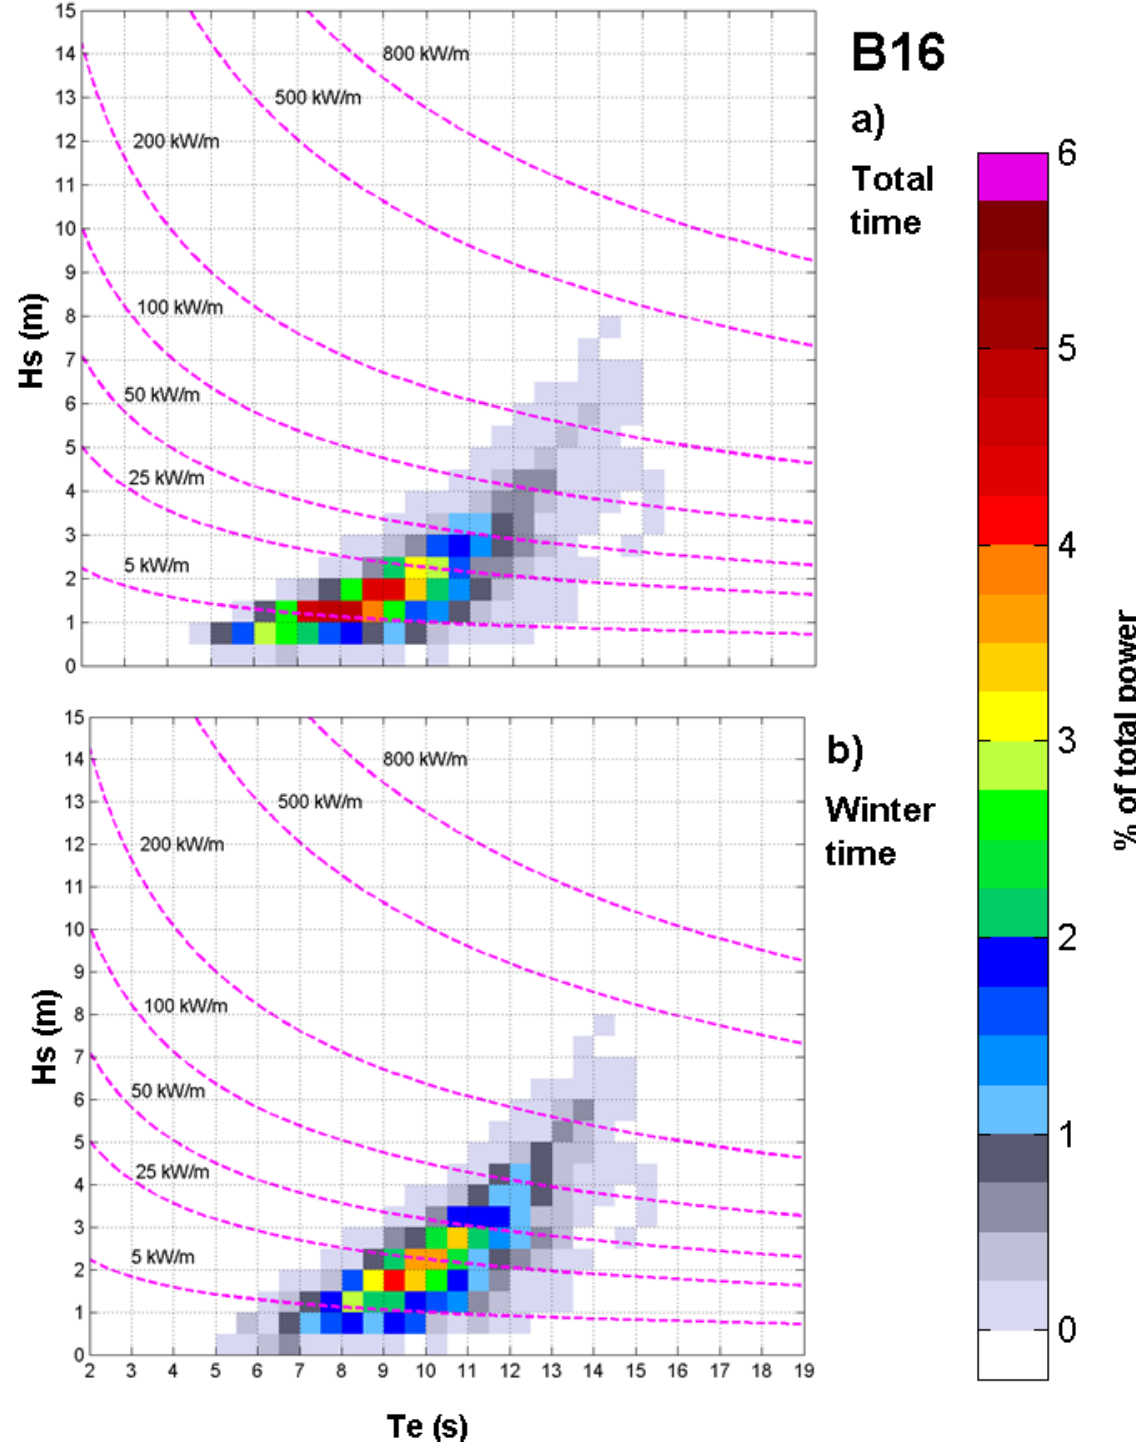
Figure 5. Reference point B16 (P9 nearshore); bivariate distributions of occurrences corresponding to the sea states defined by H 2009–2011. The color scale is used to represent the contribution of the sea state to the total incident energy, as a percentage. The wave power isolines are also represented. ( a ) Total time; ( b ) Winter